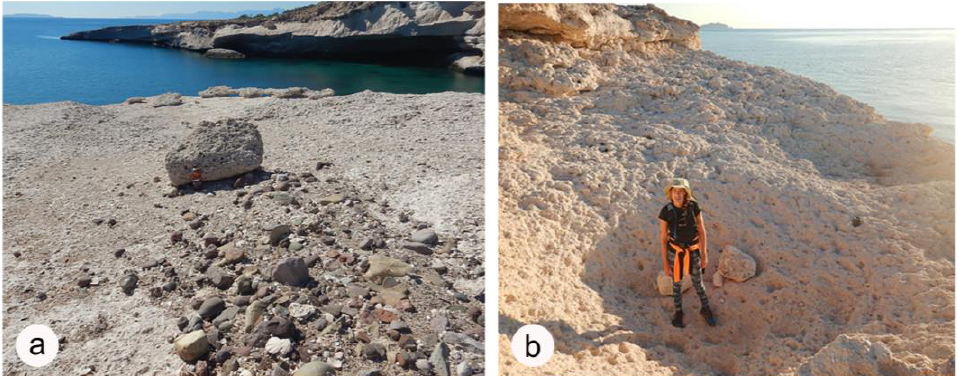
Figure 6. Photos showing evidence of mechanical erosion on the 12 m limestone terrace at Arroyo Blanco: ( a ) Large limestone boulder that formed a protective barrier against wave scour that left a line of cobbles undisturbed on the leeward side; ( b ) Large pothole eroded in limestone near the seaward edge of the limestone terrace, including small boulders that would have swirled around the inner margin during the impact of each wave (person for scale).